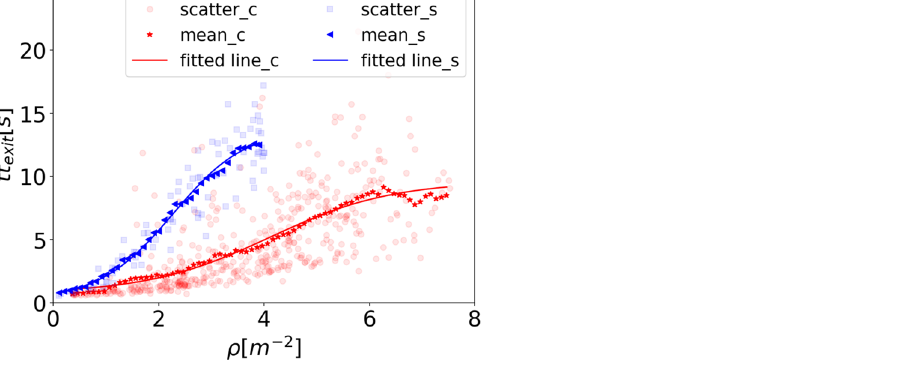
Figure 20. Relation between travel time inside the exit region tt exit and initial Voronoi density in the exit region for children (red points) and students (blue squares). Red stars and blue triangles for the mean data of children and of students, respectively. Red and blue lines highlight the fitting results of the trend.